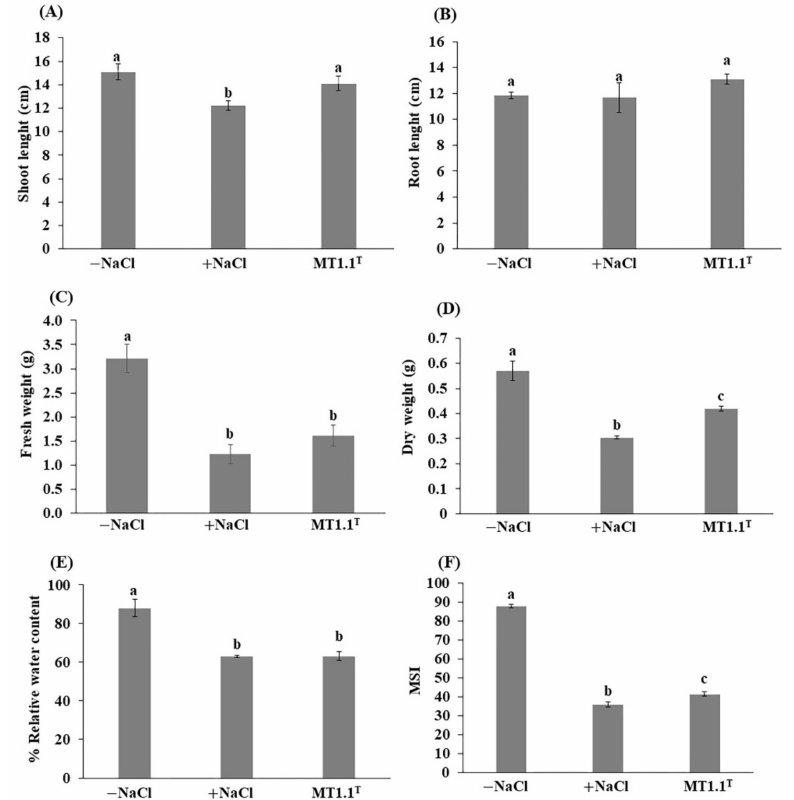
Figure 1. Promotion of tomato seedlings growth by D. abyssi MT1.1 T under 150 mM NaCl. ( A ) shoot length, ( B ) root length, ( C ) fresh weight, ( D ) dry weight, ( E ) % relative water content, and ( F ) mem- brane stability index (MSI). Data represent the mean values of three replicates. Different letters (a, b, and c) indicate a significant difference according to Duncan at p <